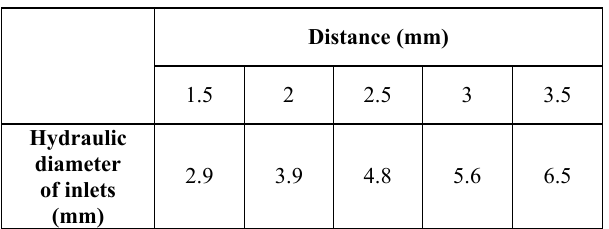
Table 2. Mesh information’s.